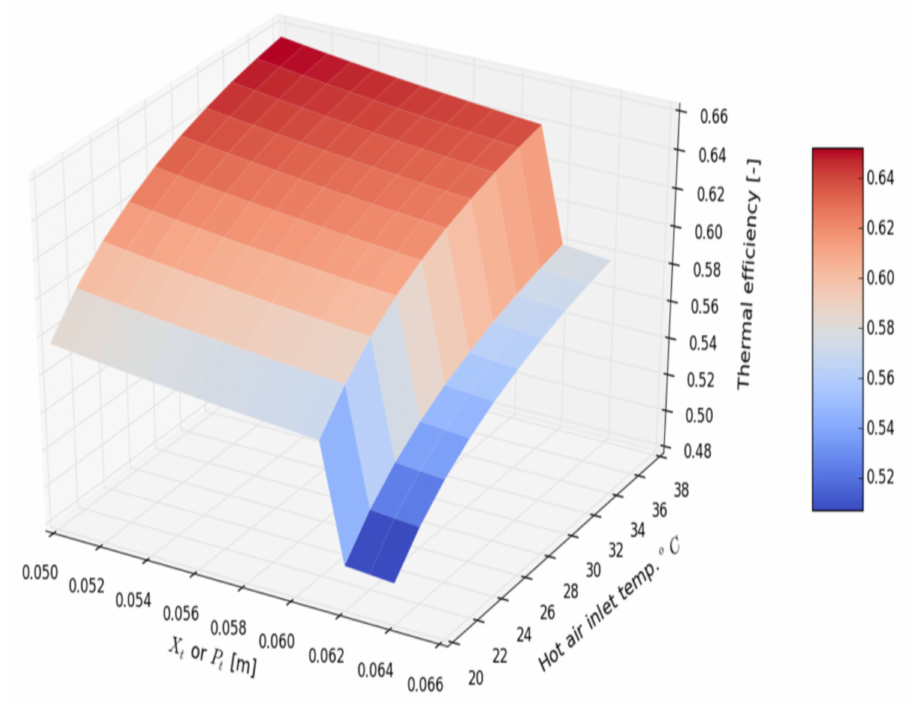
Figure 19. Thermal efficiency vs. traversal spacing of the pipes and hot air inlet